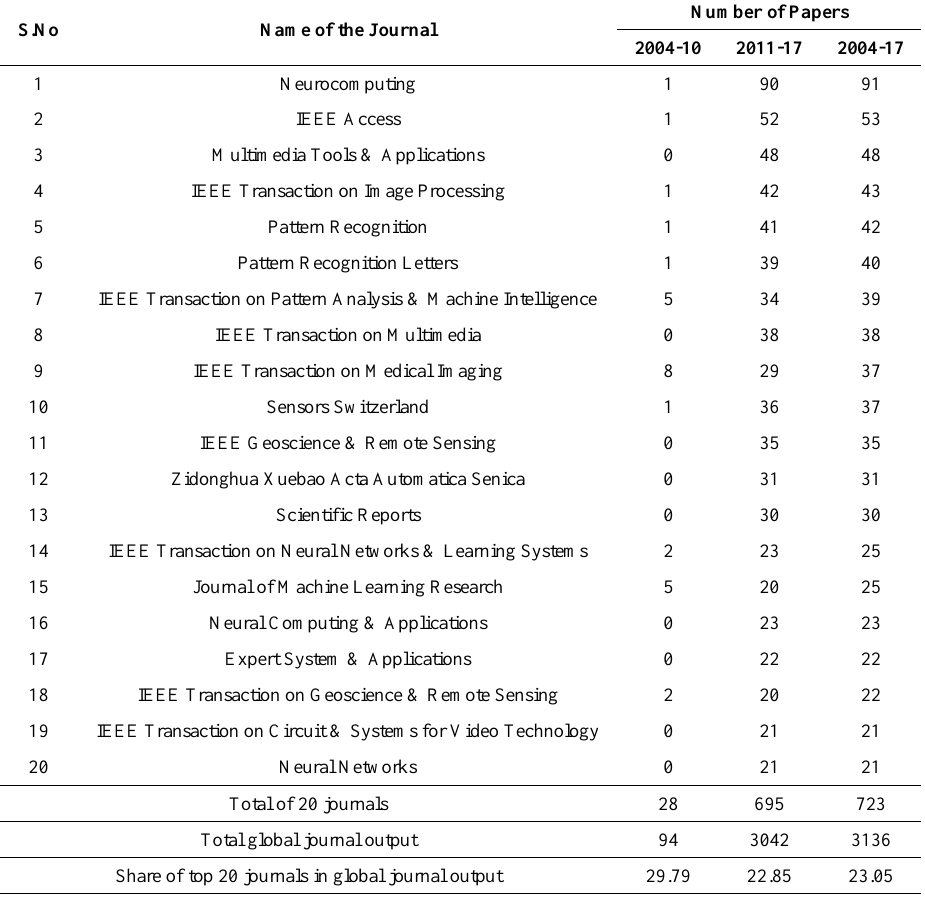
Table 7. Top 20 most productive journals in deep learning research during